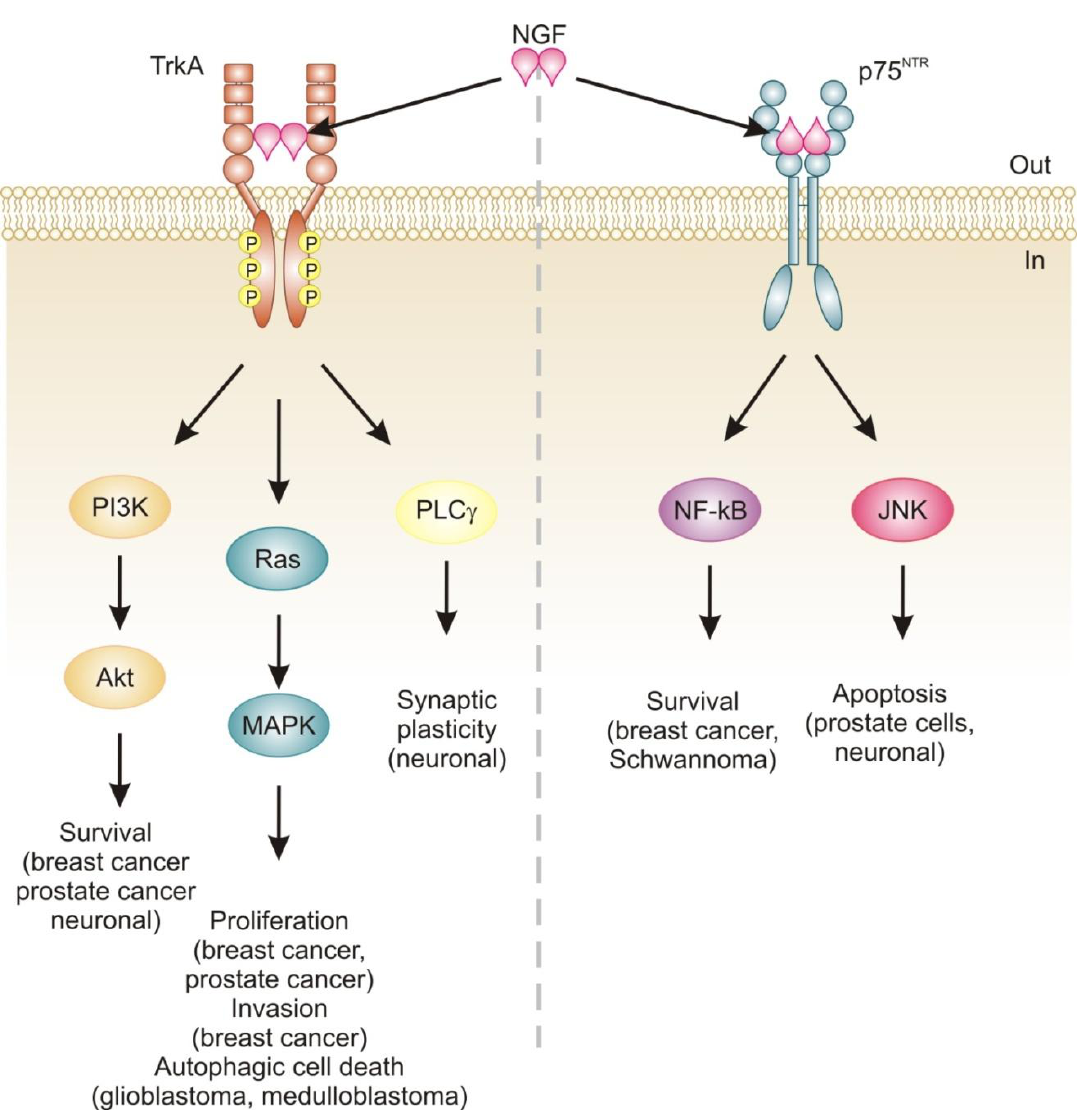
Figure 1. Signaling pathways activated by nerve growth factor (NGF). NGF binding